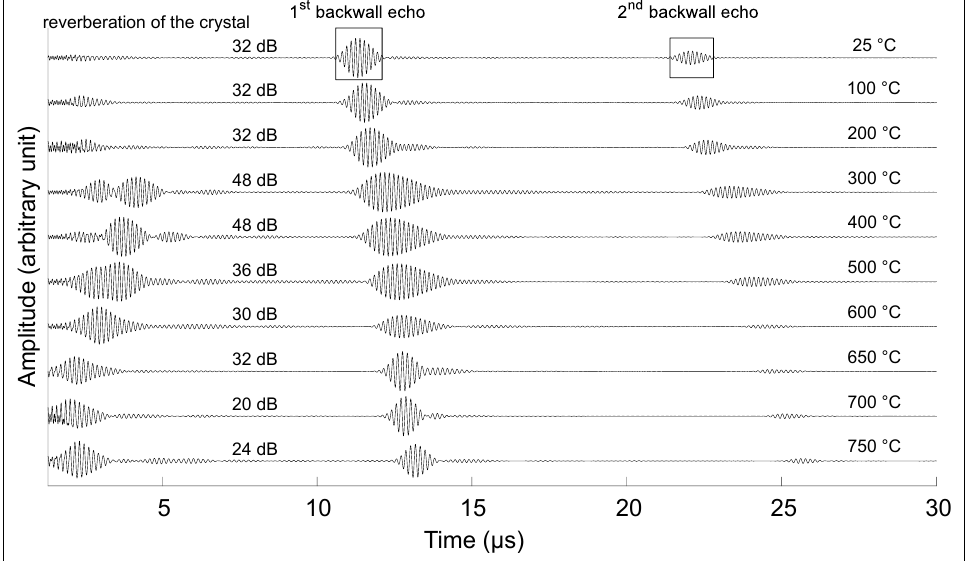
Figure 8. Signal amplitude on 32.8-mm-thick low-carbon steel block for temperatures between 25 ◦ C and 750 ◦ C, showing the first and second backwall echoes from Transducer B.